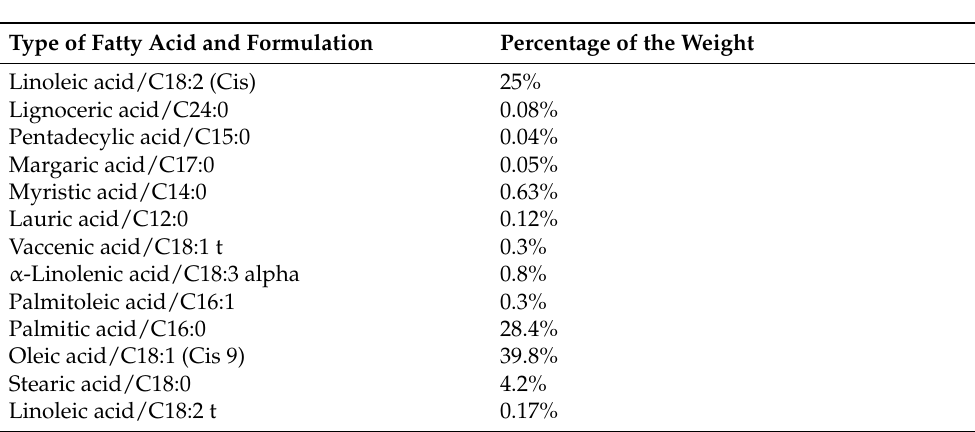
Table 8. Chemical characteristics of